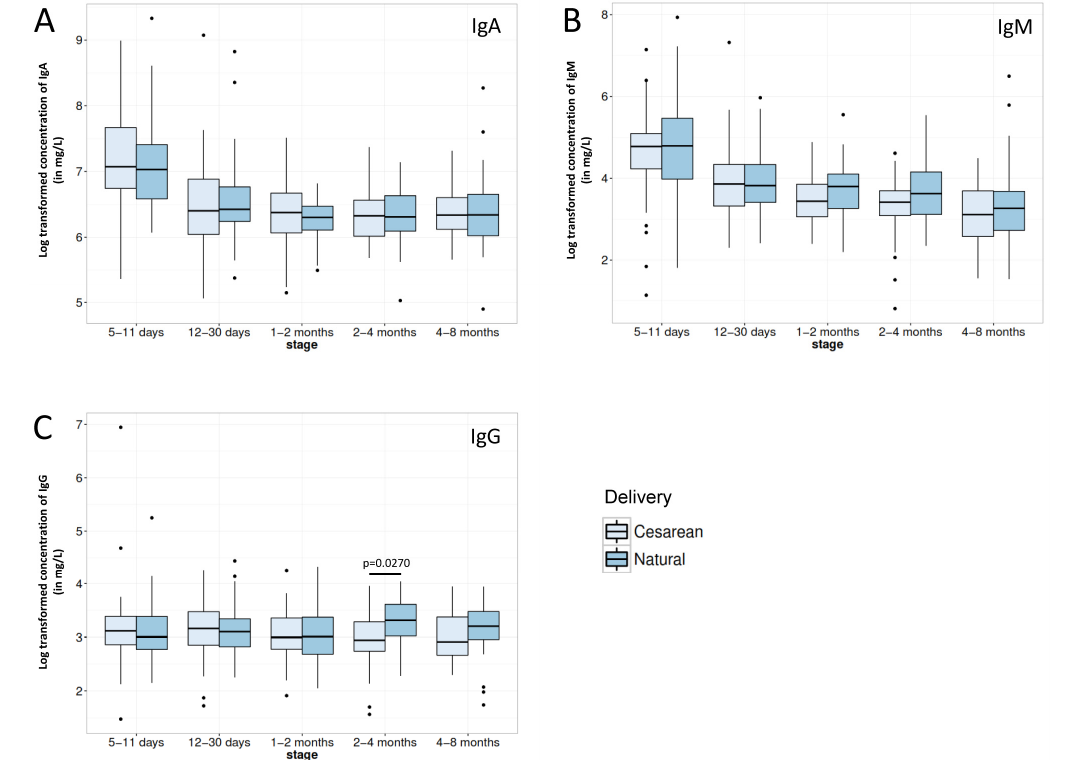
Figure 3. Comparison of ( A ) IgA; ( B ) IgM and ( C ) IgG immunoglobulin contents in breast milk from mothers delivering their infant either vaginally (Natural) or by Caesarean section for each lactation period of this study. Box plot represent medians with 25th and 75th percentile, min ‐ max range and outliers. Statistical significance was set at p < 0.05 and significant p ‐ values are indicated in the graphs.